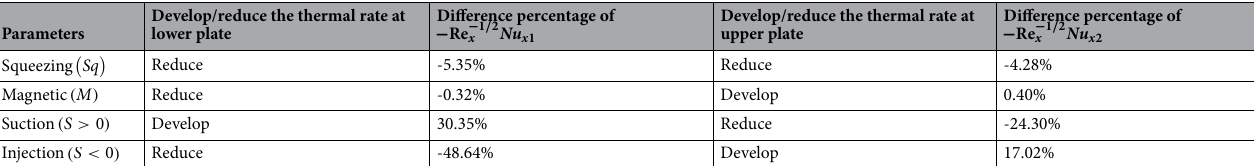
Table 7. Heat transfer analysis with the addition of the control